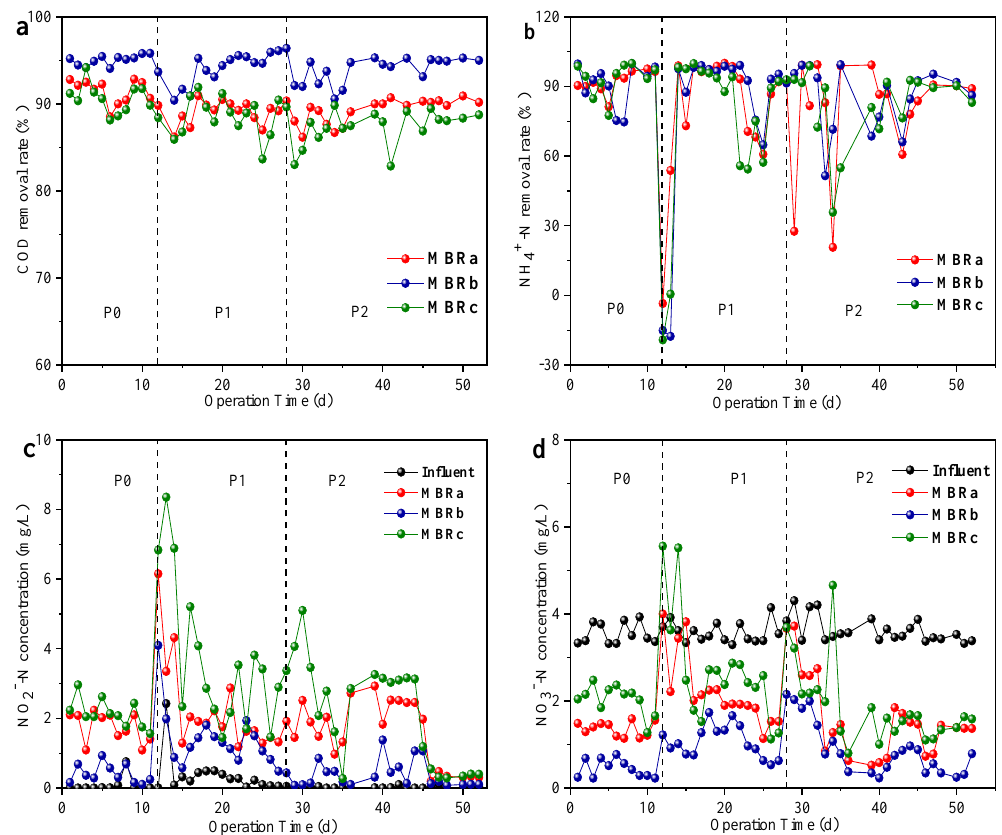
Figure 2. Removal performance of di ff erent reactors in di ff erent operating phases, COD removal rate in ( a ), NH 4 + -N removal rate in ( b ), NO 2 − -N influent and e ffl uent components in ( c ) and NO 3 − -N influent and e ffl uent components in ( d